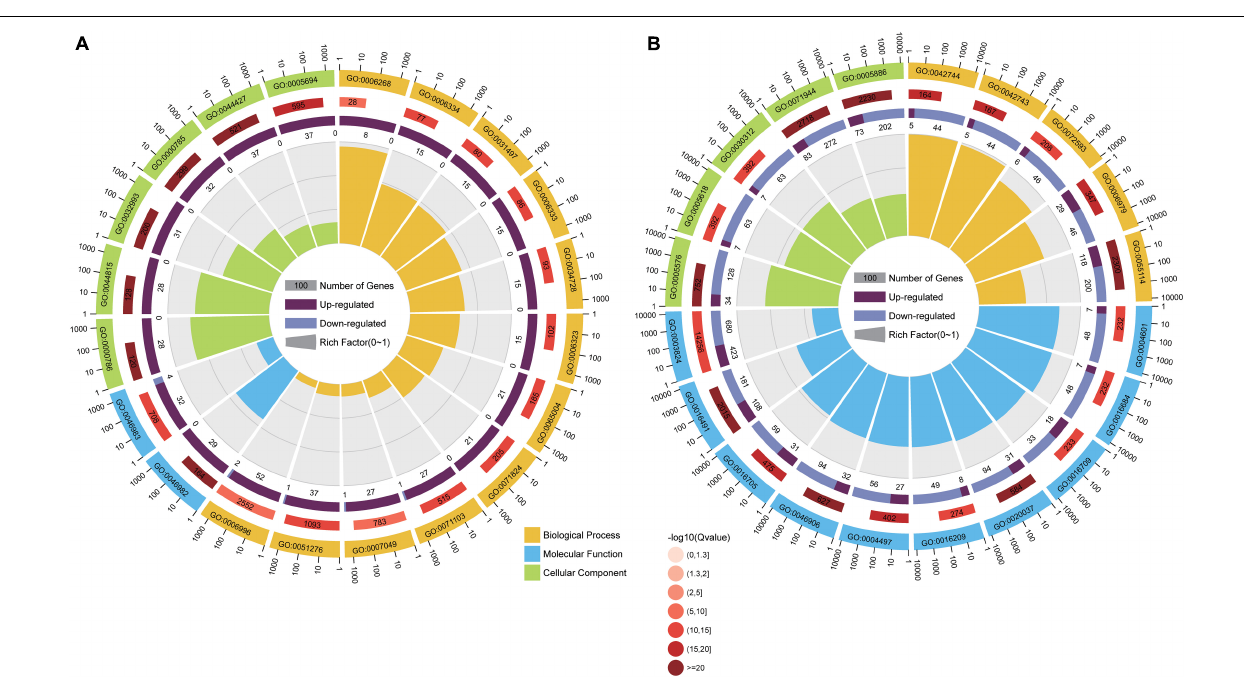
FIGURE 3 | The analysis of the top 20 enriched Gene Ontology (GO) categories of DEGs in different comparison groups, i.e., CK vs. T2 (A) and CK vs. T3 (B) . The sectors indicate GO categories. The sector colors orange, blue, and green represent the biological process, molecular function, and cellular component, respectively. The three circles from inside to outside: the first circle is the number of DEGs enriched in the corresponding GO terms. Purple bars indicate upregulated gene numbers, and blue bars indicate downregulated gene numbers; the second circle is the number of background gene numbers in the corresponding GO terms; and the third circle is the enriched GO